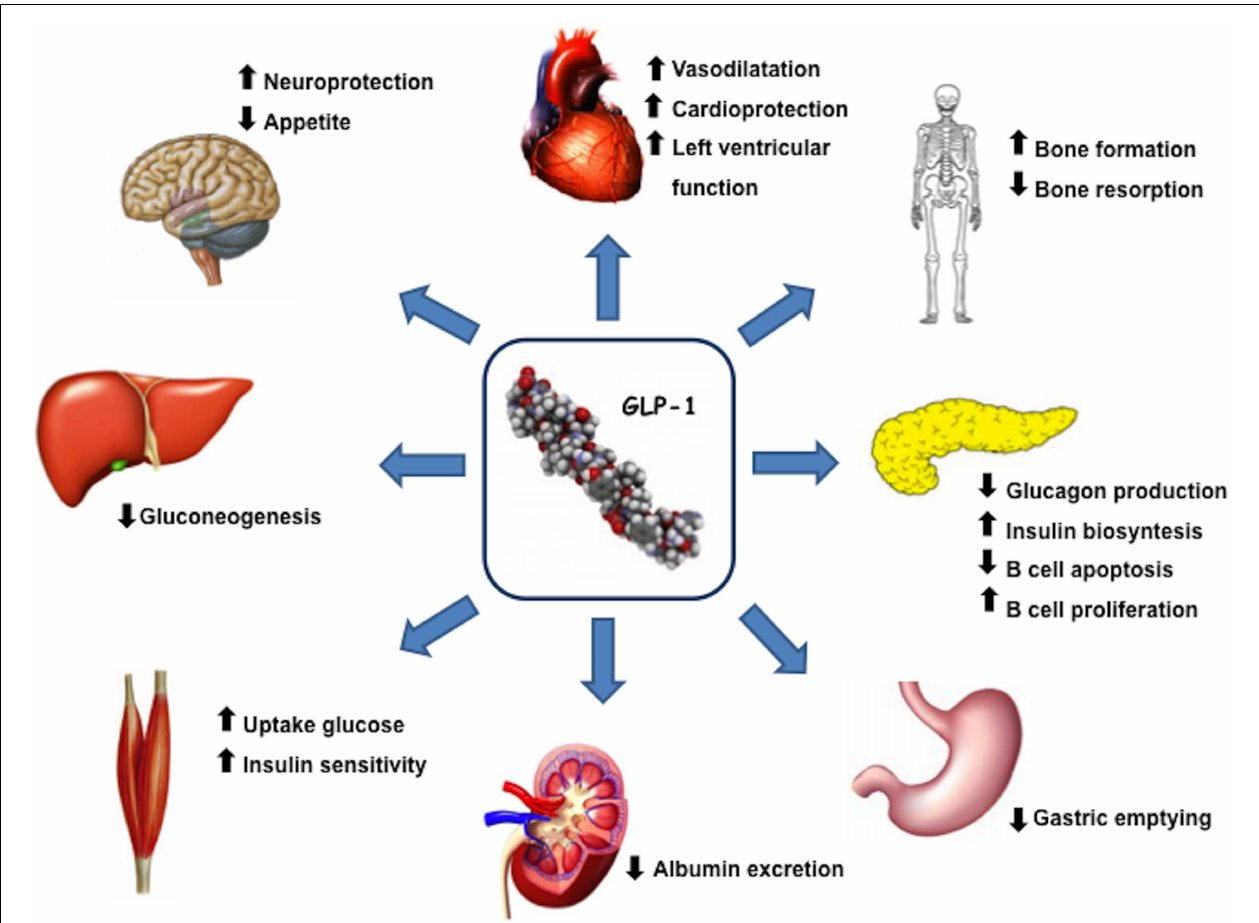
FIGURE 1 | GLP-1 actions and target organs. GLP-1, through its receptor GLP-1R, has functional effects on a variety of tissues.